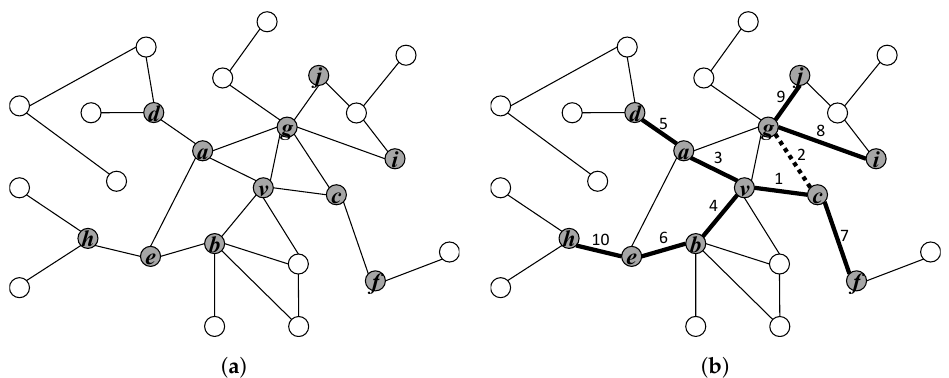
Figure 2. Tree generation under Sample-Tree Generation (STG). ( a ) An example network graph. Gray circles denote the set of infected nodes V I . ( b ) A tree generated by STG. Given v as a root, a tree marked by thick edges is generated under STG. Each number on the edges denotes the order that the edge is added. Due to the detour at ( c , g ) , it is a non-Breadth First Search (BFS)